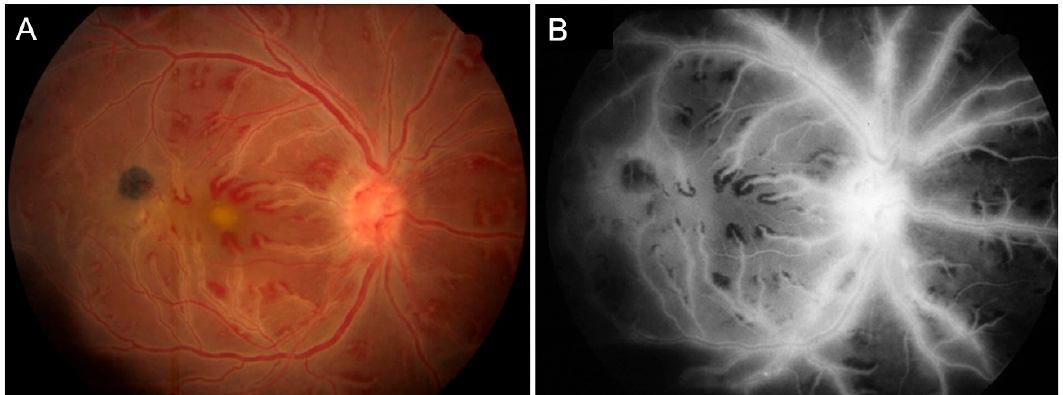
Figure 13. The figure shows fundus photograph of a patient with sarcoid-associated retinal vasculitis with exuberant retinal vessel sheathing, ( A ) suggestive of frosted branch angiitis. Fluorescein angiography ( B ) shows extensive retinal vascular leakage due to the intense inflammatory response.